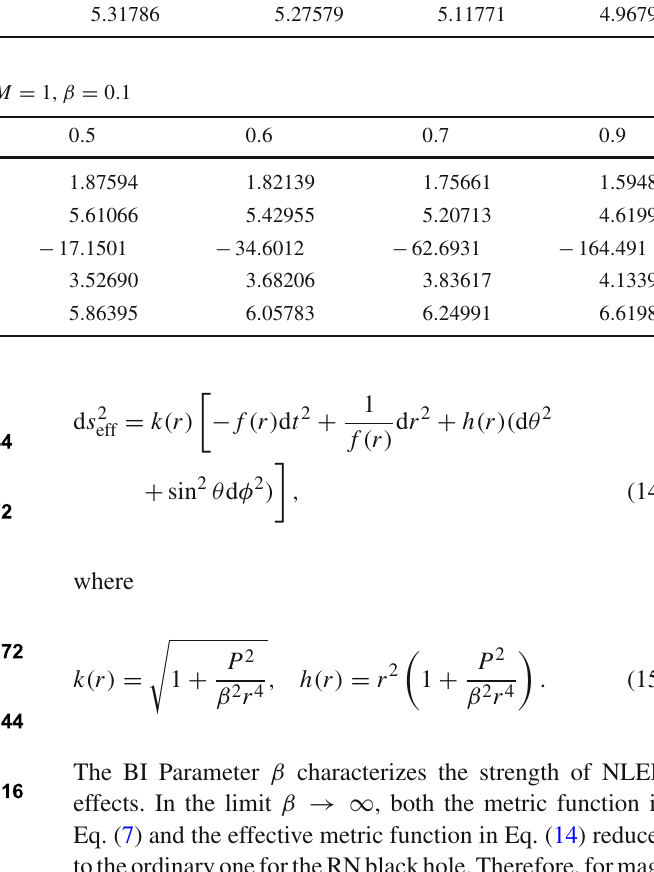
Fig. 2 Contour plot in β − P space with fixed M = 1. The colors represent the value of r ISCO − 3 r h , and the contours are the isosurfaces of r ISCO − 3 r h . On the bolded curve, r ISCO = 3 r h . The impact of the magnetic charge P is opposite to the BI parameter β below the bolded curve, and vice